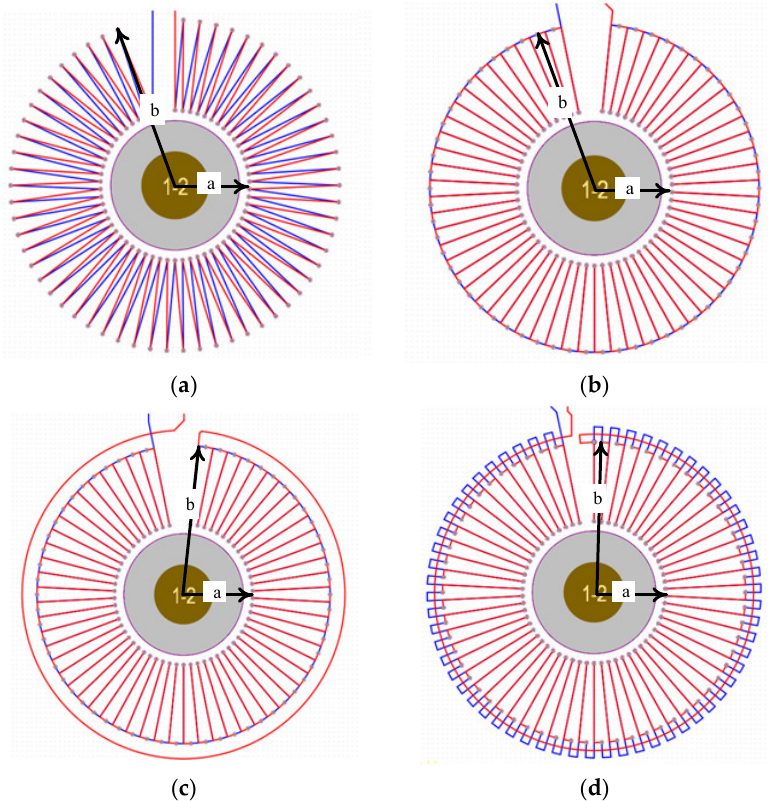
Figure 4. PCB Rogowski coil with four different winding methods. ( a ) Coil 1. ( b ) Coil 2. ( c ) Coil 3. ( d ) Coil 4. Coil 1 connects the top (red) alignment to the bottom (blue) alignment through holes on the inside and outside [42], with a rectangular wire turn cross-section. This coil has a relatively simple wiring structure, but the individual wire turns formed by the top and bottom alignments are not centrally symmetrical, and no return loop is provided. Coil 2